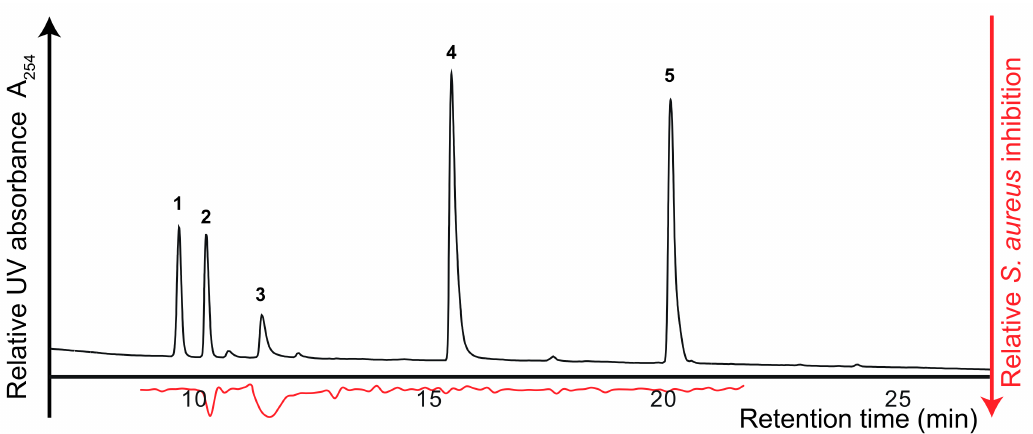
Figure 4. HPLC chromatogram at 254 nm of a test mixture of S. aureus inhibitors and inactive compounds, separated on a C 18 column. The corresponding high-resolution S. aureus growth inhibition profile is shown below in red, pinpointing compounds 2 and 3 as S. aureus growth